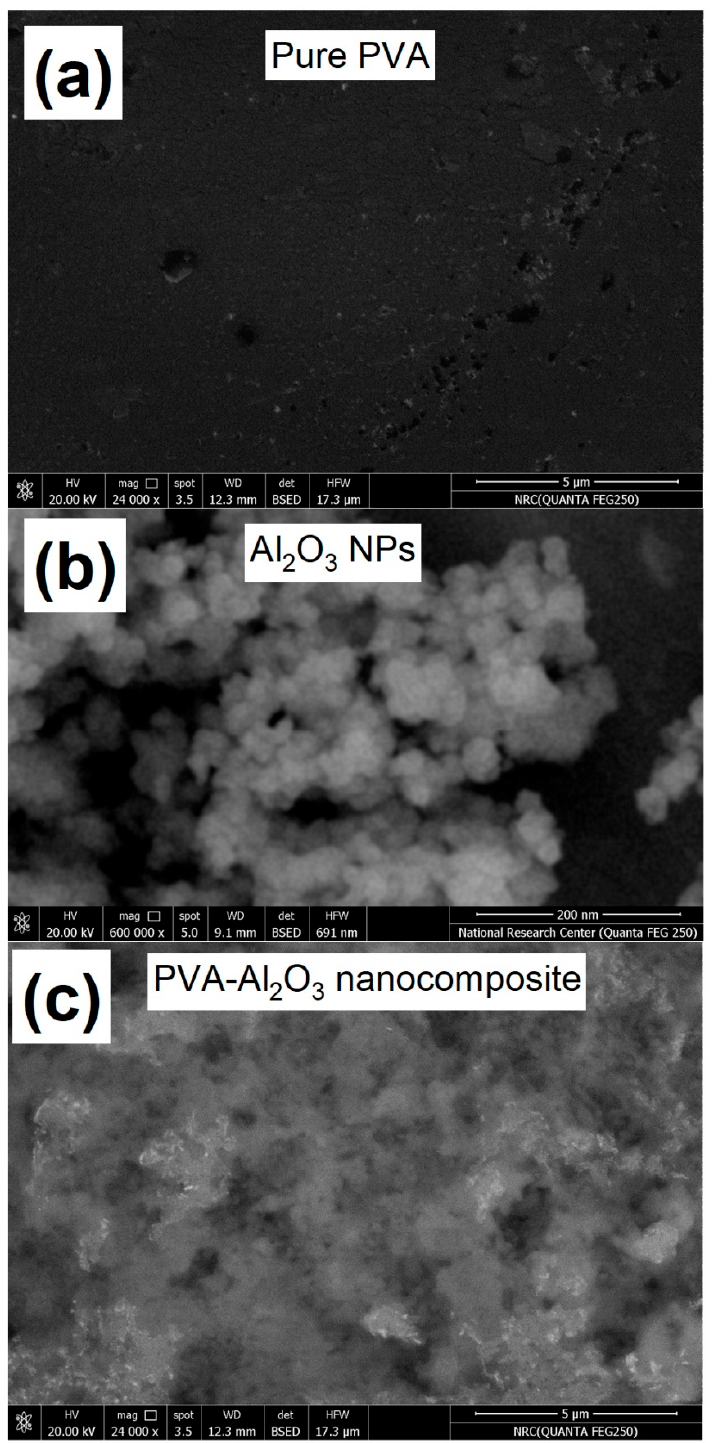
Figure 3. SEM image of ( a ) PVA, ( b ) Al 2 O 3 nanoparticles, and ( c ) Al 2 O 3 /PVA